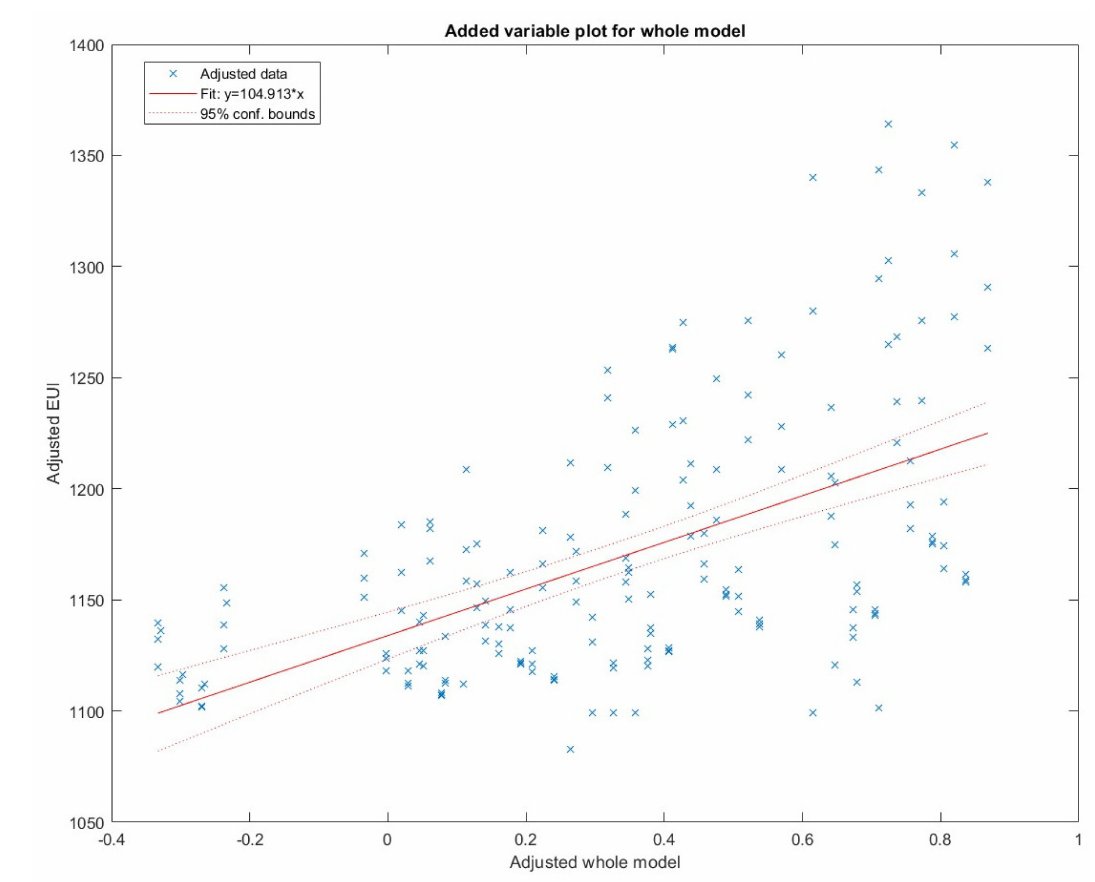
Figure 7. General data distribution and best-fitted